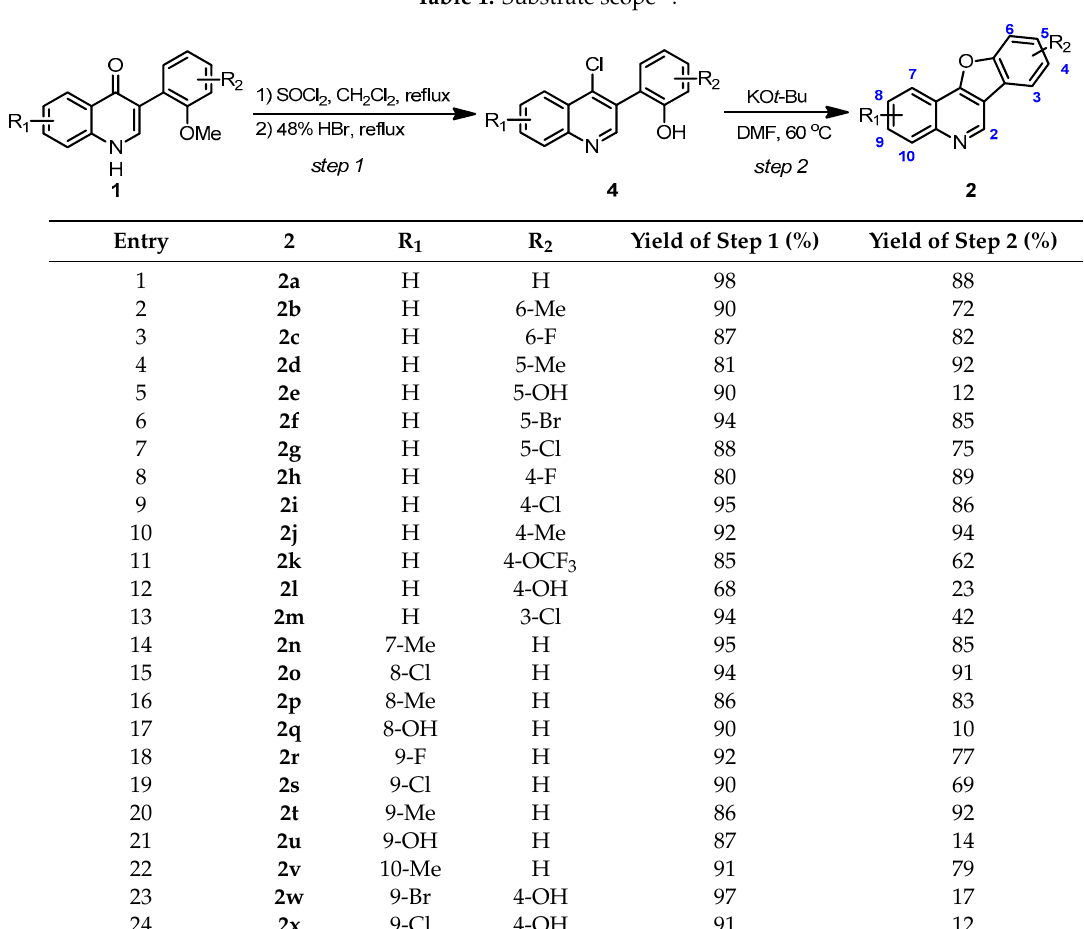
Table 1. Substrate scope 1 .